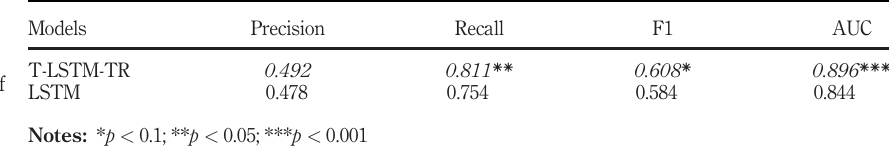
Table IV. The performances of T-LSTM-TR and LSTM